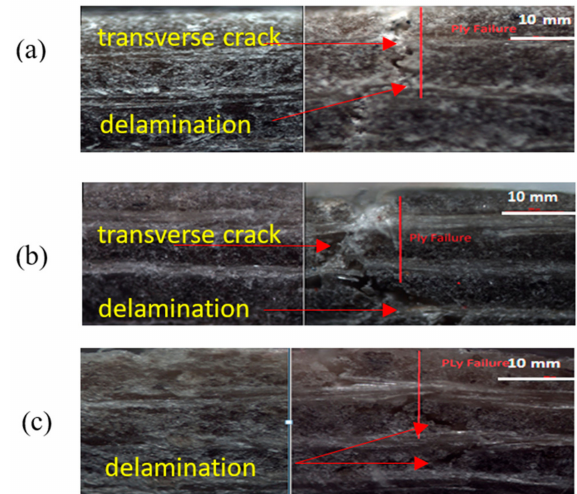
Figure 9. Optical micrograph of fractured specimen of flax fibre composites ( a ) B-flax, ( b ) E-flax and ( c ) P-flax at 50 ×